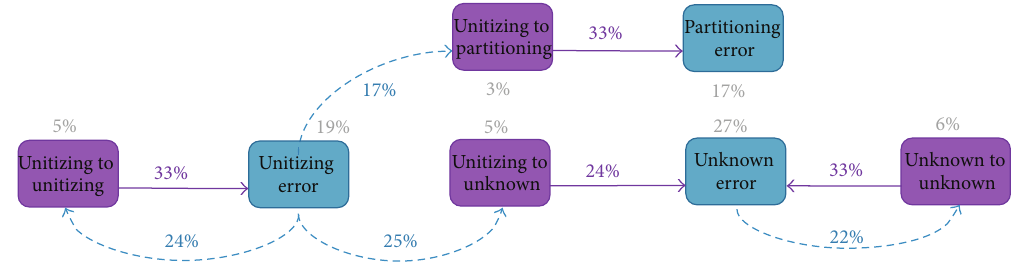
Figure 3: Extended state transition diagram for Level